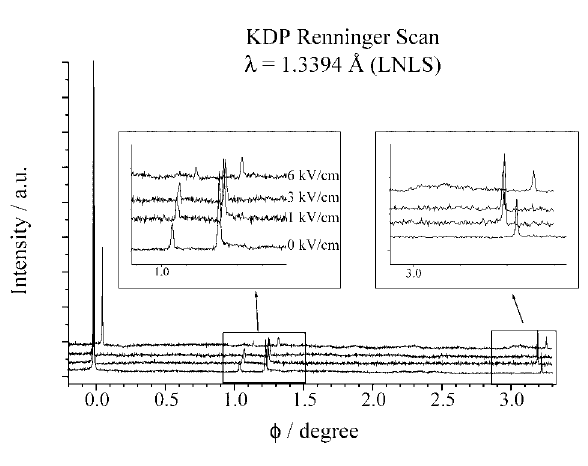
Figure 5. Effect of the electric field in the KDP (080) Renninger scan. Insets show details of the peak